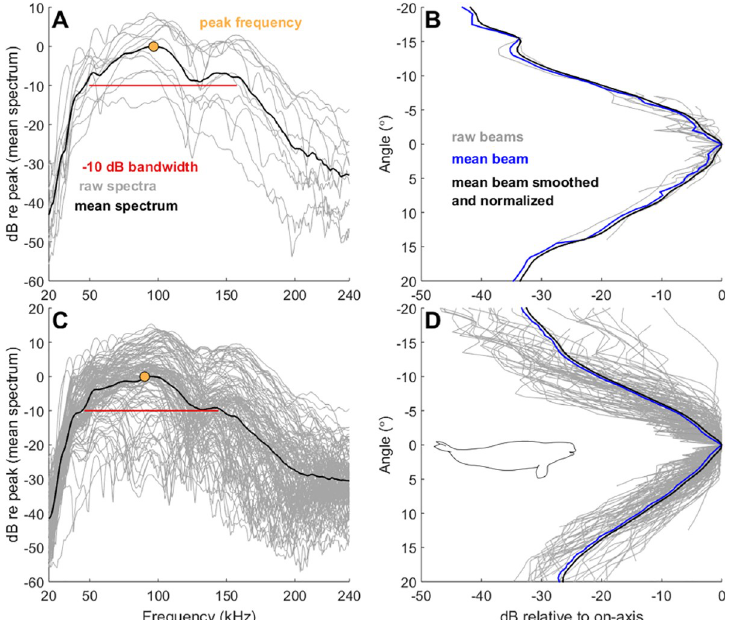
Fig 5. Beluga echolocation click spectra and beam pattern for on-axis clicks. (A) Beluga spectra and (B) vertical beam pattern for 12 on-axis clicks in both the vertical and horizontal planes. (C) Beluga spectra and (D) vertical beam pattern for 133 on-axis clicks in only the vertical plane. Spectra in (A) and (C) show raw spectra in gray, mean spectrum in black, peak frequency with a yellow point, and -10 dB bandwidth in red. Vertical beam patterns in (B) and (D) show raw beam patterns in gray, mean beam pattern in black, and the smoothed and normalized beam pattern in blue; negative angle values correspond to the dorsal vertical beam and positive values refer to the ventral beam. https://doi.org/10.1371/journal.pone.0257054.g005 dorsal beam width for on-axis clicks in the vertical plane (Paired t -test: p = 0.015) and on-axis clicks in both planes (Paired t -test: p = 0.010). ICIs were approximately 100 ms for selected on- axis clicks and associated click sequences (Table 2).